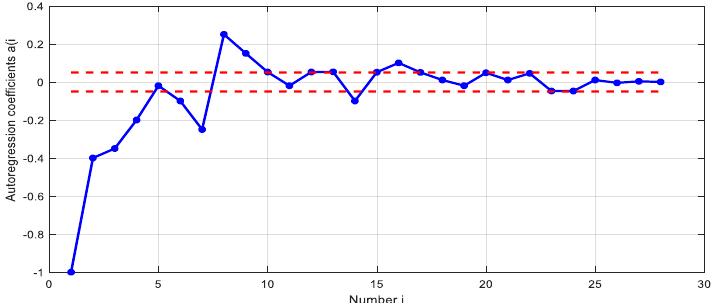
Figure 6. Estimation of autoregressive coefficients (blue line) with confidence intervals (red dashes).